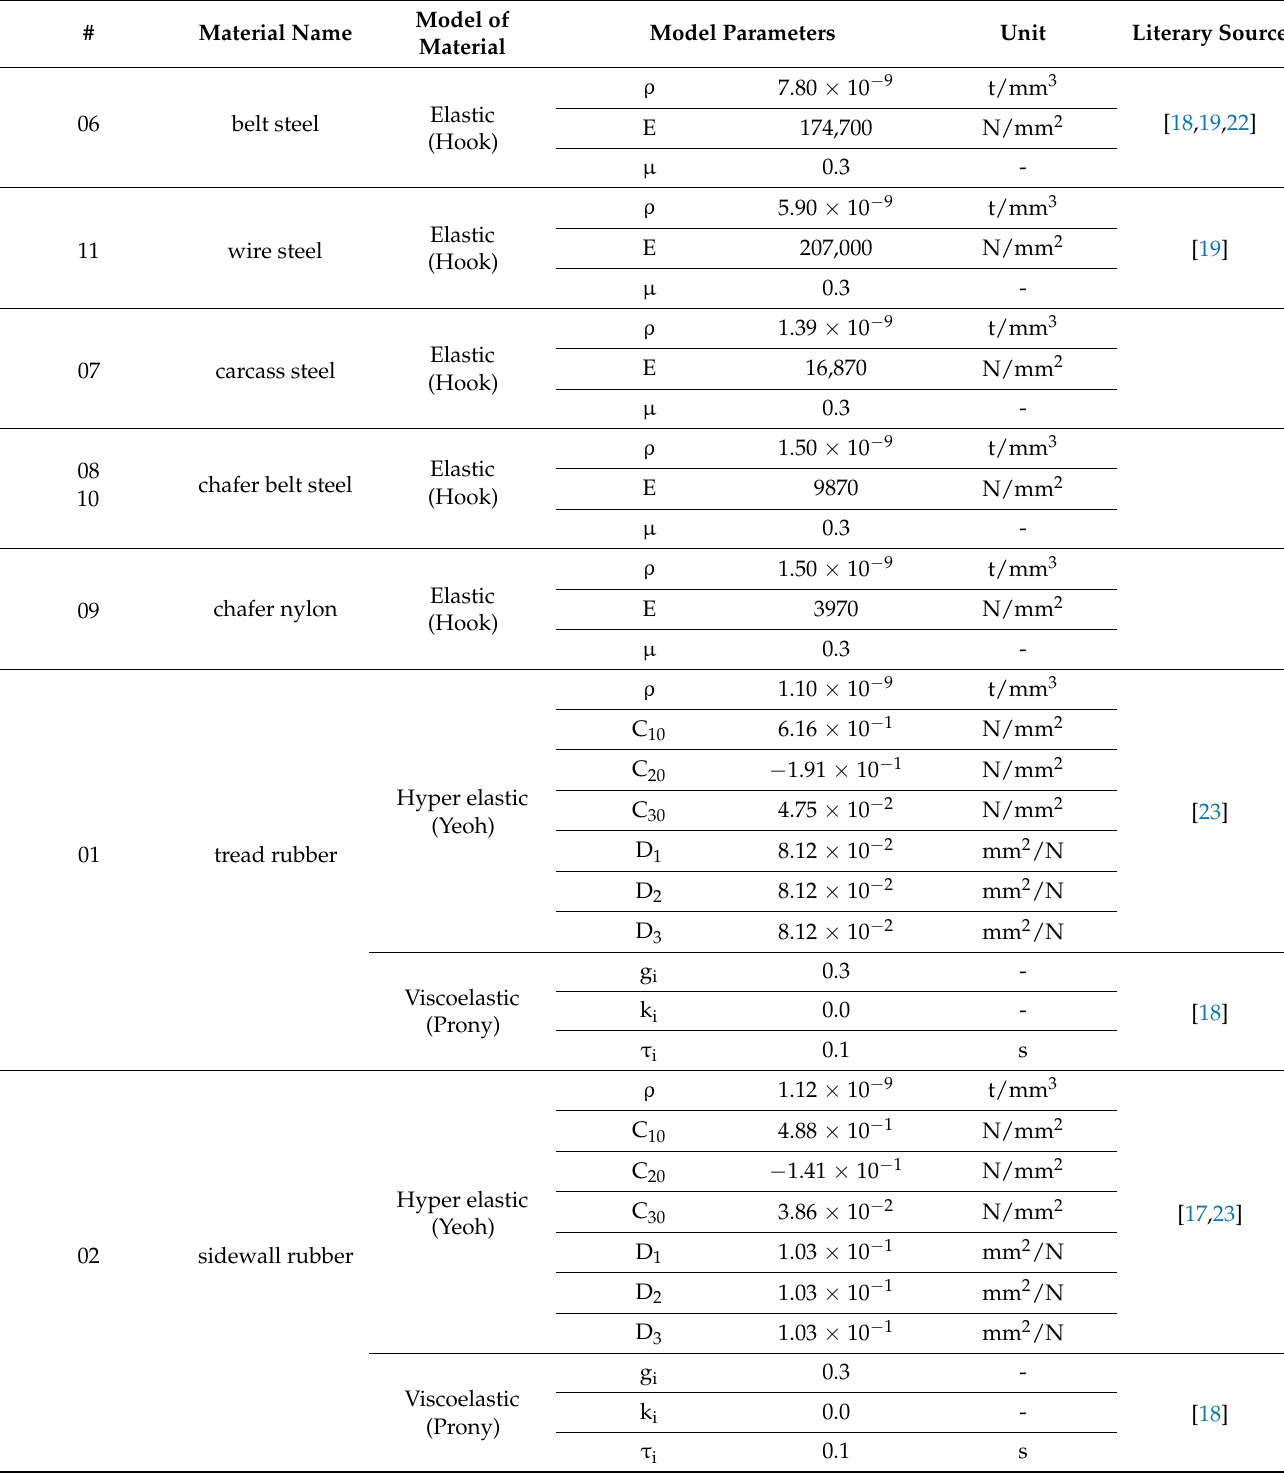
Table 4. Material parameters of the composite structure of the DTA 275/80R22.5-type